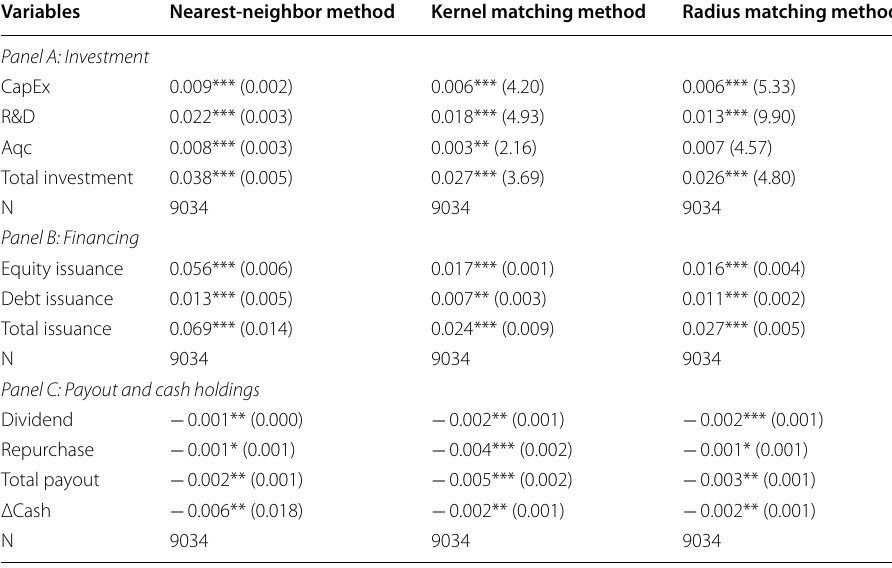
Table 5 Propensity score